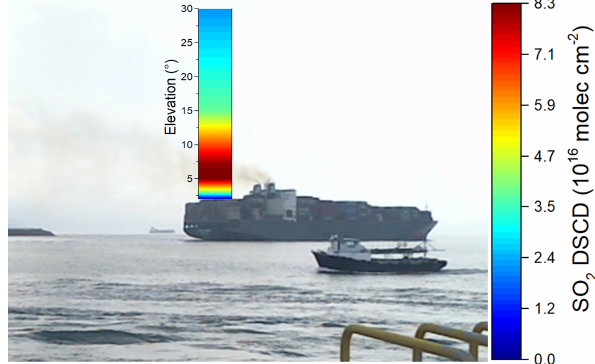
Figure 11. A typical distribution of SO 2 DSCDs in the smoke plume of a ship on 22 June